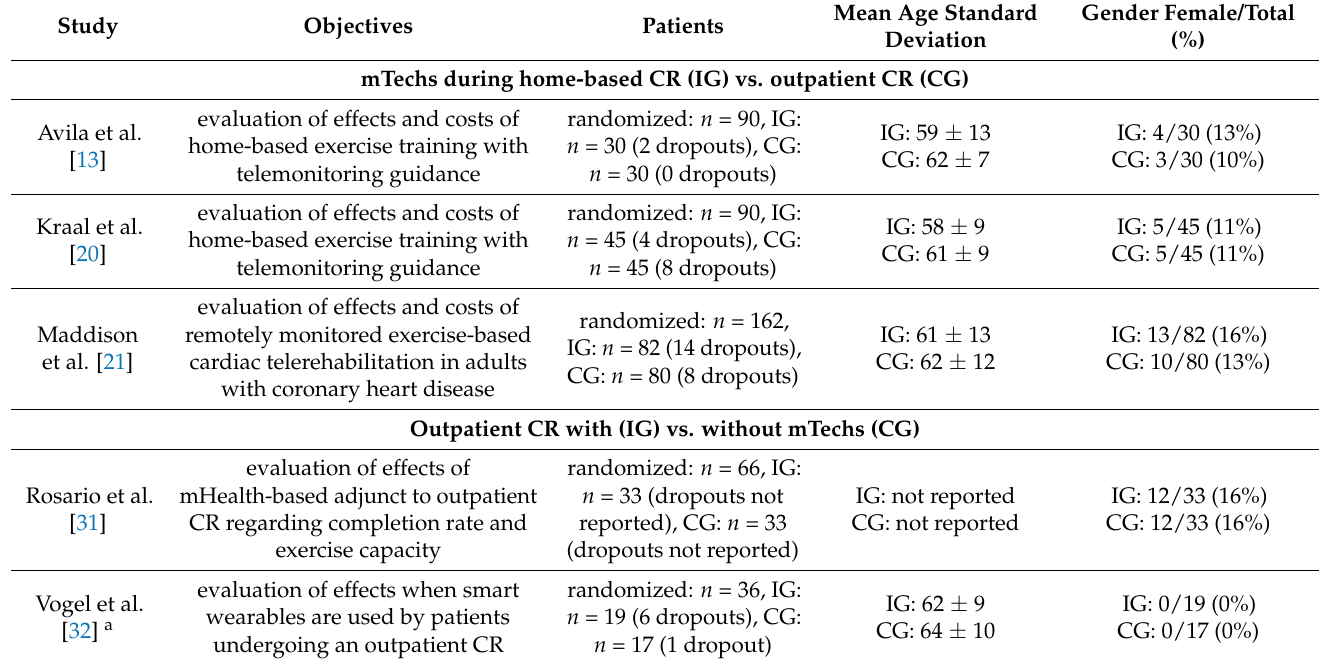
Table 1. Study objectives and patient